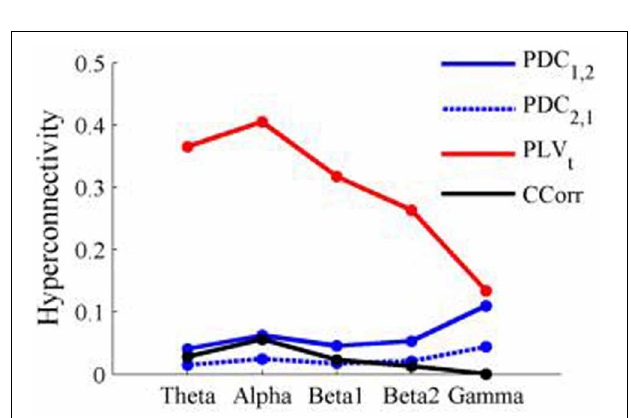
that there was a significant change in connectivity from the pre- to the post-stimulus periods between the first member of a pseudo-pair and the second member. Red lines indicate an increase in connectivity from the pre- to the post-stimulus period and blue lines indicate a decrease. For PDC 1 , 2 , lines connecting electrode sites between the heads show that neural activity in the first member of a pseudo pair was more predictive of the neural activity of the second member of the pair in the post-stimulus period than in the pre-stimulus period. Allocation to first or second member of the pseudo-pair was arbitrary.